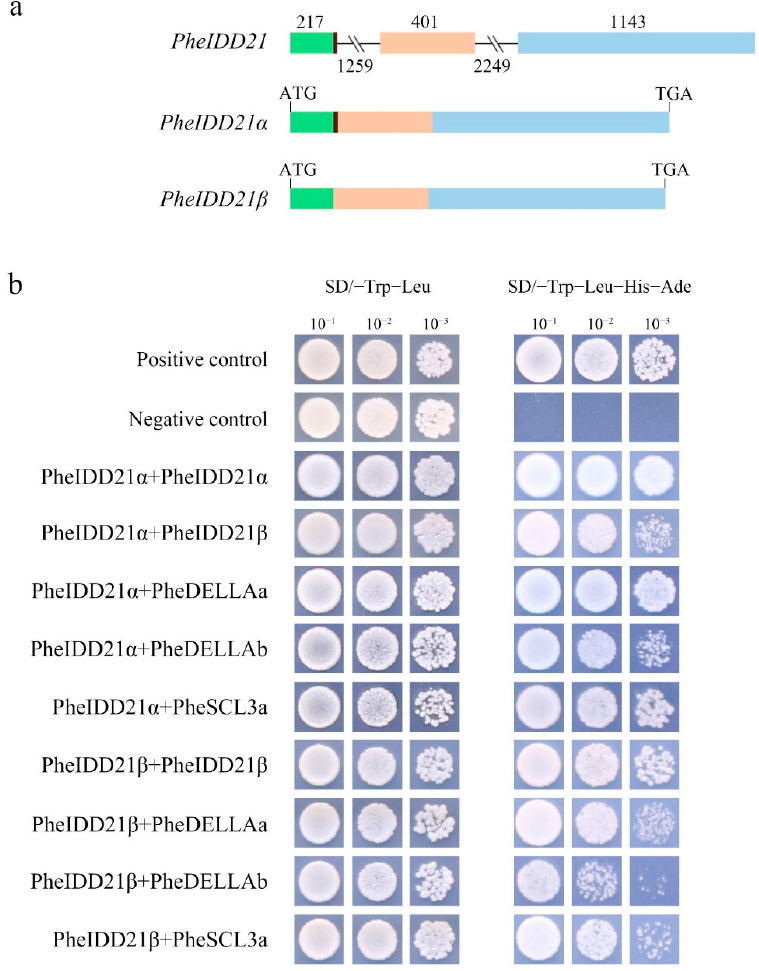
Figure 10. Genomic structures of PheIDD21 splice variants ( a ) and Y2H assays for interacting proteins of both isoforms ( b ). Lines indicate introns, and boxes of different colors indicate exons. The numbers above the boxes indicate the exon lengths, and the numbers below the lines indicate the intron lengths. ATG indicates the start codon, and TGA indicates the stop codon.